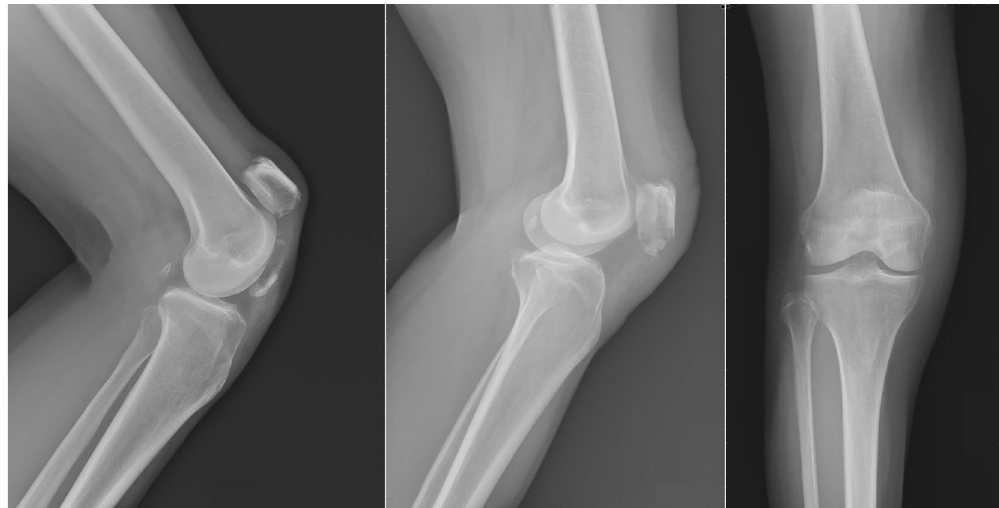
Figure 2. A patellar distal pole fracture was treated with patellar tendon reattachment due to unable to perform the tension band wire fixation.